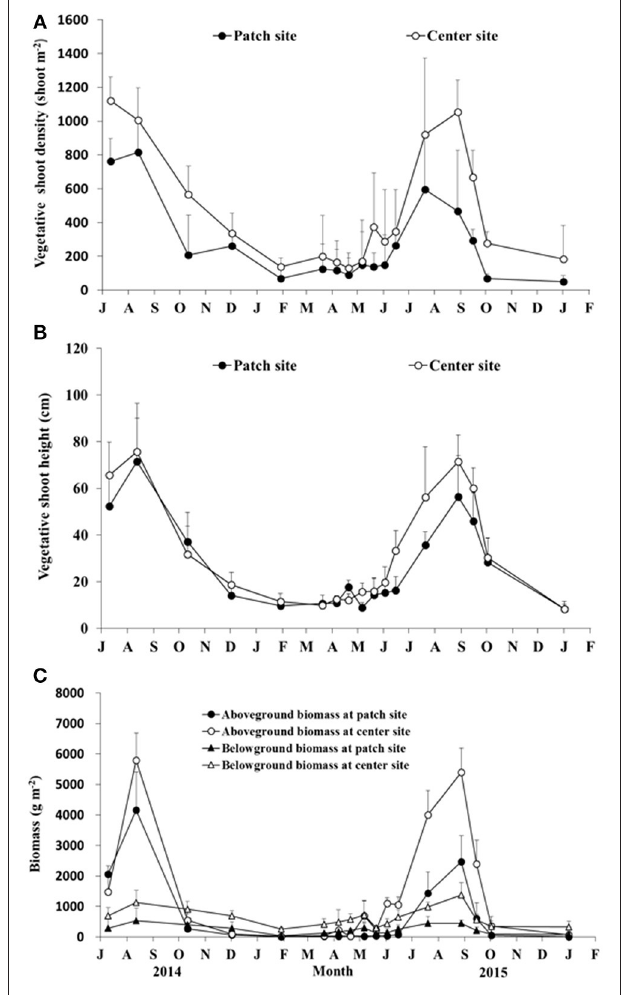
FIGURE 5 | Temporal changes in the vegetative shoot density (A) , shoot height (B) , and biomass (C) of Zostera marina in Swan Lake. Values are means ± sd